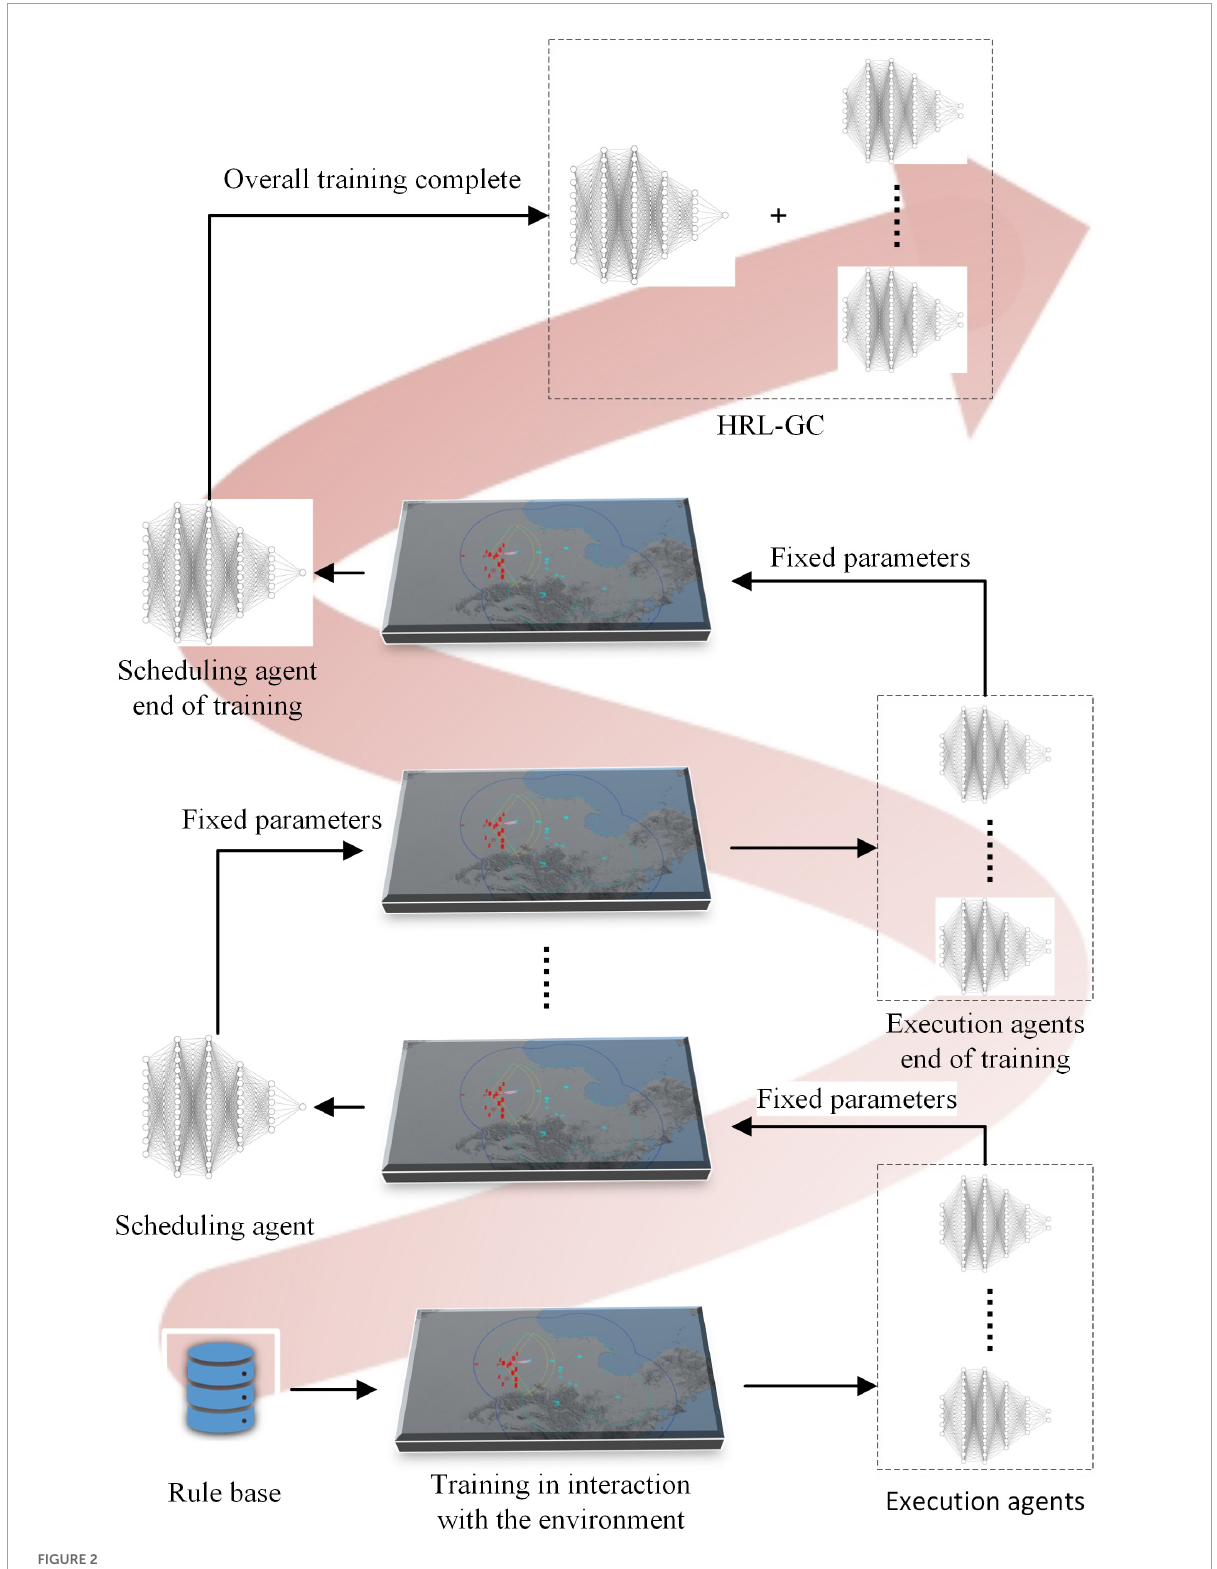
FIGURE2 Hierarchical training